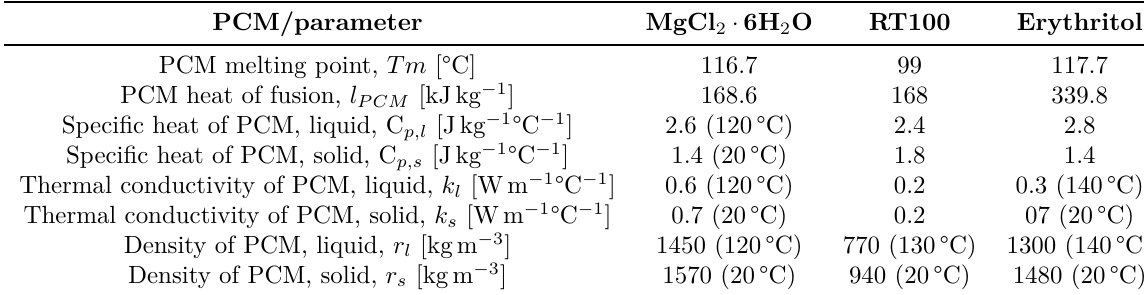
Table 1. Main parameters of the selected